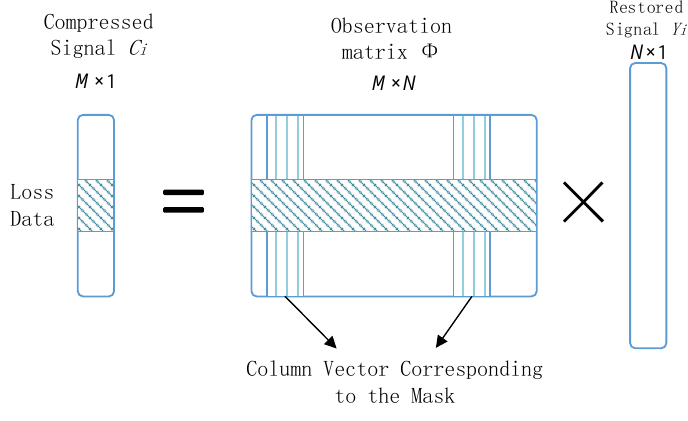
Figure 16. Correspondence between each encoded data packet and the row vector of the observation